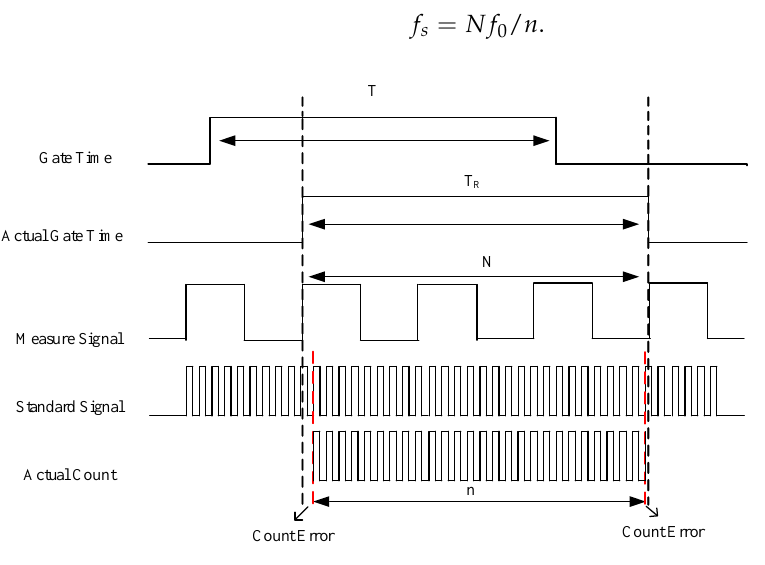
Figure 15. Sequence of polarization and reception controlled by ARM and CPLD. As shown in Figure 16, T is the preset gate time, which is controlled by signal quality. T R is the actual measurement time and starts at the first rising edge in T and ends at the last rising edge after T . N is the number of cycles of the measured square wave signal, and n is the number of cycles of the reference signal generated by a 4 MHz temperature- compensated crystal oscillator (TCXO) with 2 ppm stability. T R can be expressed by the following formula where f s is the frequency of FID signal. f 0 is the frequency of the reference signal. Thus, the frequency of the measured signal can be calculated by